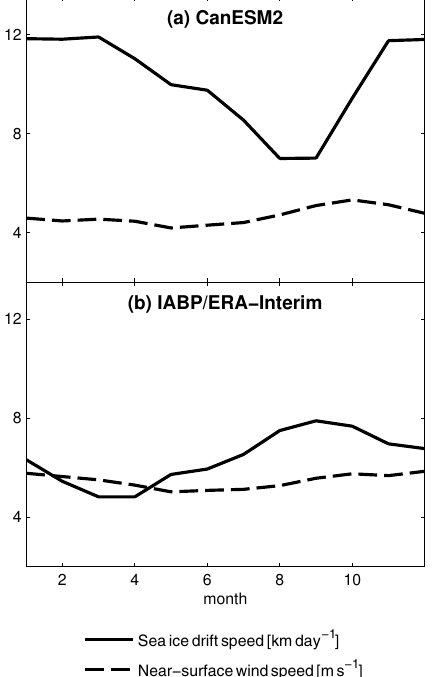
Figure 10. (a) Seasonal cycle of Arctic average sea ice drift speed (solid, in units of kmday − 1 ) and near-surface wind speed (dashed, in units of ms − 1 ) from a historical run of CanESM2 averaged over 1979–2005. The spatial domain used for the calculation is the region north of 68 ◦ N for longitudes east of 103 ◦ E and west of 124 ◦ W and north of 79 ◦ N at all other longitudes, excluding grid points within 150km of a coastline. This focuses on regions of year-round drift- ing ice and excludes landfast ice. (b) as in (a) but using non-gridded drift speed measurements from the International Arctic Buoy Pro- gramme (solid; Tschudi et al., 2016) and near-surface wind data from ERA-Interim (dashed; Dee et al.,